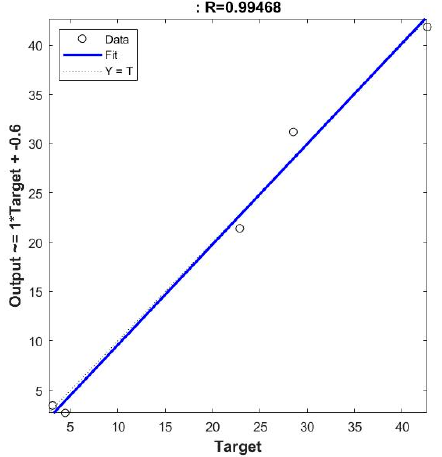
Figure 8. Neural network model. Measured vs. Predicted Values.